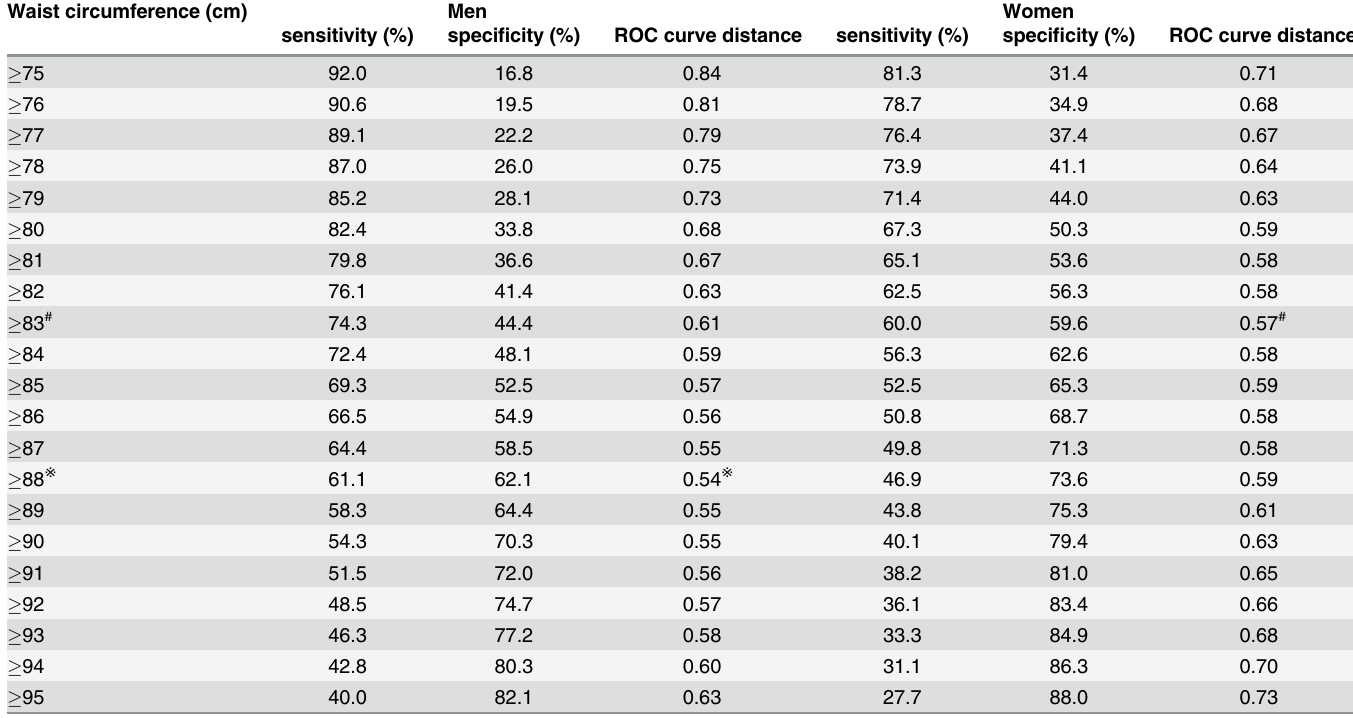
# = the optimal cut-off point of waist circumference for women. ※ = the optimal cut-off point of waist circumference for